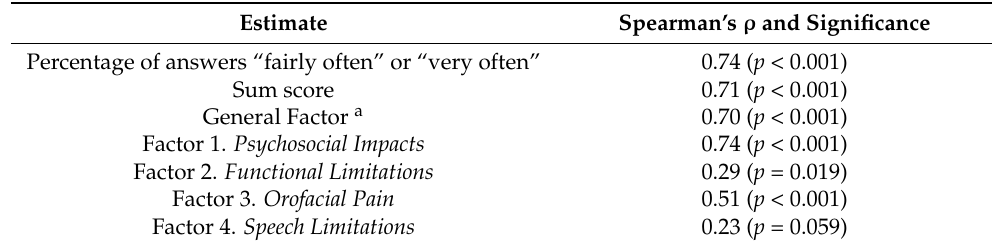
Table 5. Results of convergent validity analysis: correlation between the estimates of OHIP-LT and self-reported dental health scores.